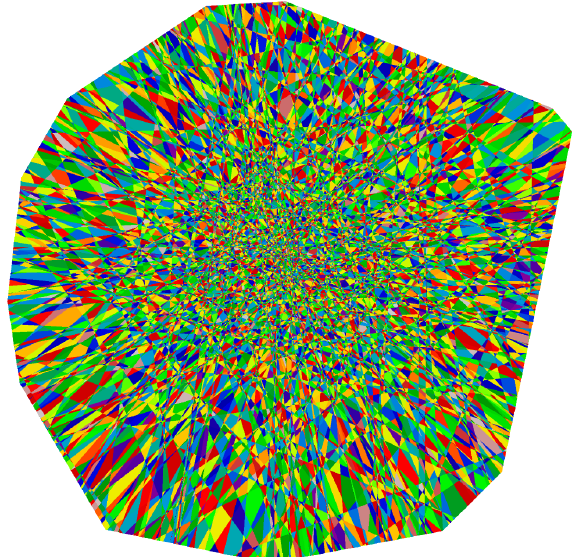
Figure 1 . A cross-section of the secondary fan of fine, regular, star triangulations of the largest polytope in the Kreuzer-Skarke database (with h 1 , 1 = 491) , with neighboring triangulations corre- sponding to the same Calabi-Yau combined. Each interior boundary corresponds to a bistellar flip, which induces star-crossing singularities on divisors. Figure courtesy of Andres